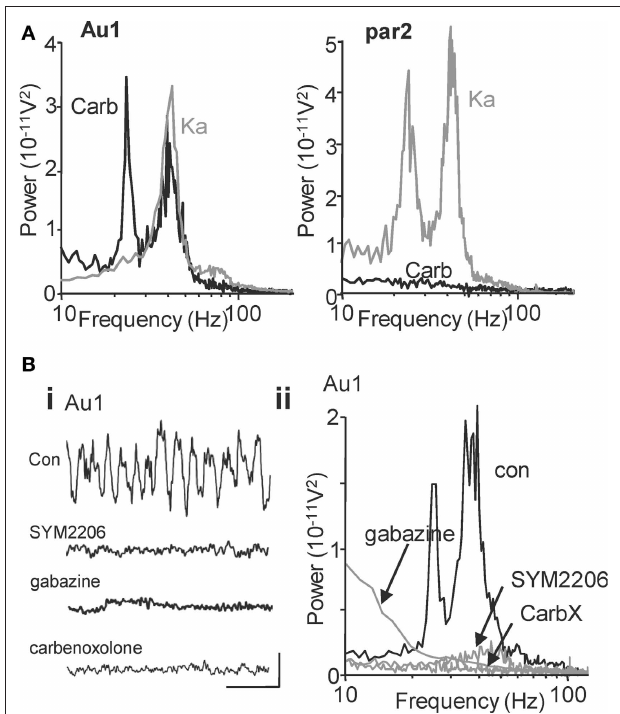
FiGurE  | Cholinergic neuromodulation generates beta and gamma oscillations in primary auditory cortex: Spectral but not mechanistic similarity to glutamatergic rhythms in association cortex. (A) Power spectra of local field potential activity in layer IV of primary auditory cortex (Au1) induced by cholinergic neuromodulation (carb, black line) or glutamatergic excitation (Ka, grey line). Layer IV recordings reveal field potential activity originating in both adjacent superficial (layer III) and deep (layer V) layers and thus permit direct visual comparison (e.g. Roopun et al., 2006). Note both manipulations generate gamma rhythms but only cholinergic modulation induces a beta rhythm. In contrast, power spectra of local field potential activity in layer IV of association cortex (par2, right graph) show no rhythm generation by cholinergic modulation (carb, black line), but a spectrally similar pattern of gamma and beta2 rhythms induced by glutamatergic excitation (Ka, grey line). (B) Auditory cortical beta rhythms depend on excitatory and inhibitory synaptic activity in contrast to those seen in par2 (Roopun et al., 2006). (Bi) Five-hundred milliseconds traces showing extracellular activity in the presence of carbachol. Scale bars: 100 μV, 100 ms. (Bii) Power spectra of activity from layer IV in the 1 ° auditory cortex after carbachol (15 μM) application (black trace) and after 60 min of SYM2206 (25 μM) application (grey line, top graph), gabazine application (500 nM, grey line, middle graph) and carbenoxolone (100 μM, grey line bottom